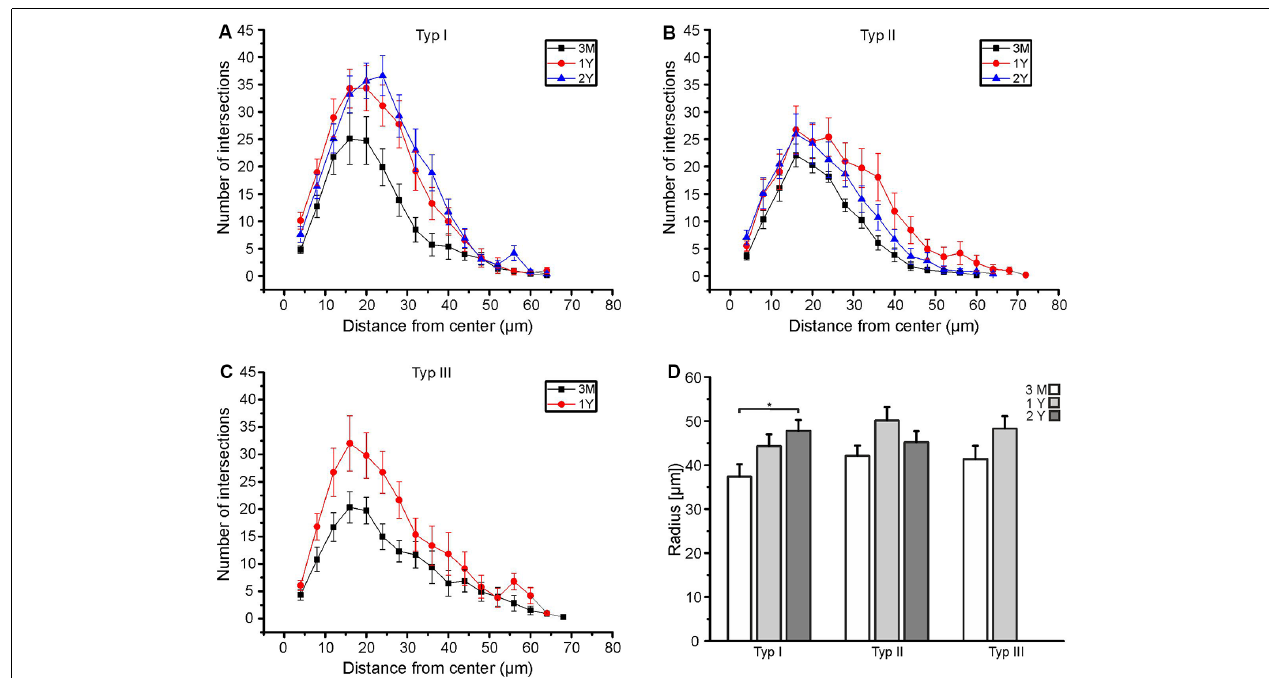
FIGURE 3 | Age-dependent Sholl analysis of astrocytes. (A) Sholl plot of type I astrocytes, (B) type II astrocytes and (C) type III astrocytes at an age of 3 months (black), 1 year (red), and 2 years (blue). (D) Averaged maximum radii of all astrocytes analyzed. Type I astrocytes significantly increased in the maximum radius between 3 months and 2 years (* p <